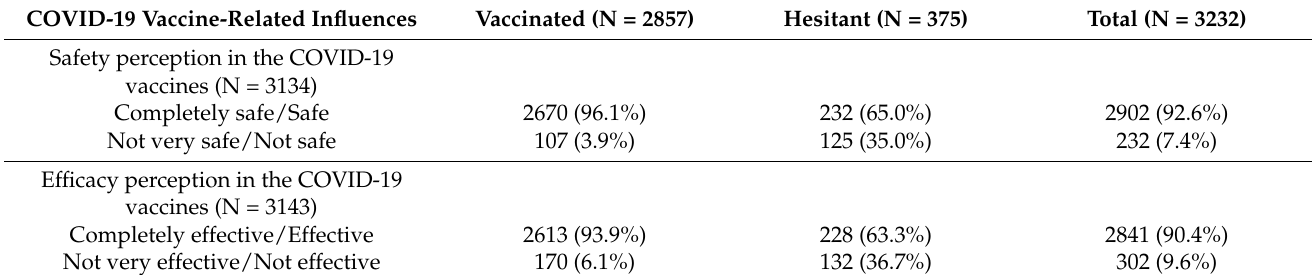
Table 5. Sample characteristics according to COVID-19-vaccine-related